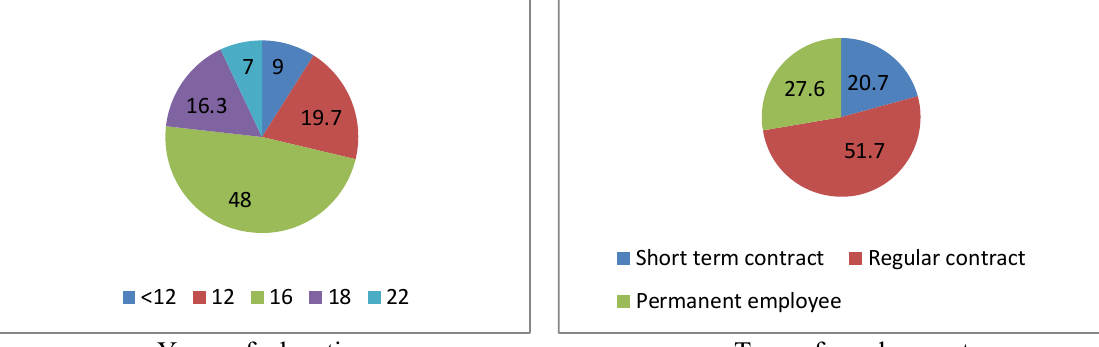
Fig. 1. Personal characteristics of the